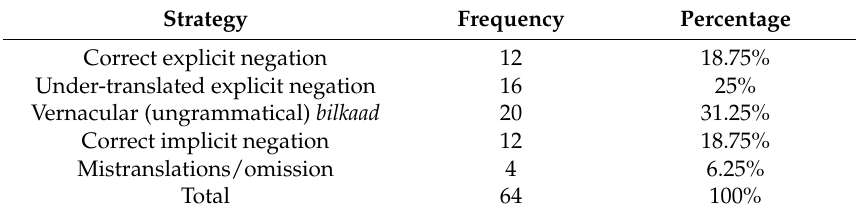
Table 4. Frequency and percentage of translation strategies in rendering -ly negation. Strategy